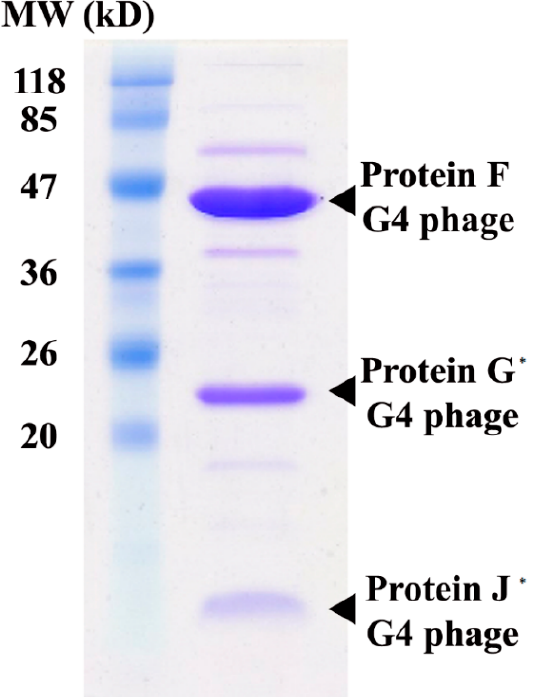
Figure 2. SDS-PAGE of the purified phage. The major band was identified as G4 F protein using mass spectrometry. The J and G proteins are denoted with asterisks (*) since they are only tentatively identified from the molecular weight.